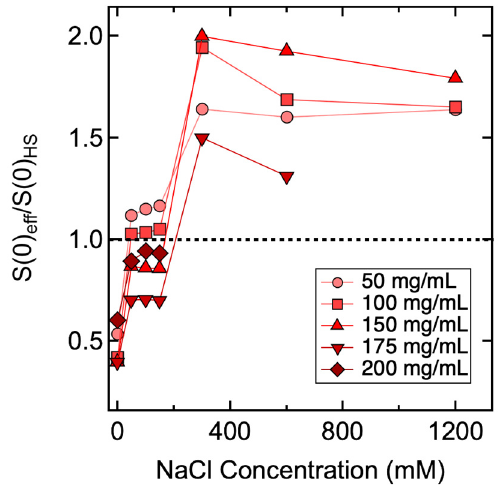
Figure 4. Summary of S (0) eff / S (0) HS ratios measured from ASA-IgG2 antibody solutions with varying mAb and NaCl concentrations. The dotted line represents a cut-off value of 1. Lines between data points are added to guide the eye. A ratio less than 1 implies the presence of repulsive interactions in addition to steric repulsion, whereas a ratio greater than 1 implies the presence of both repulsive and attractive interactions. Uncertainties in this plot are propagated from the standard errors in S (0) eff values; error bars are smaller than the plotting symbols in this